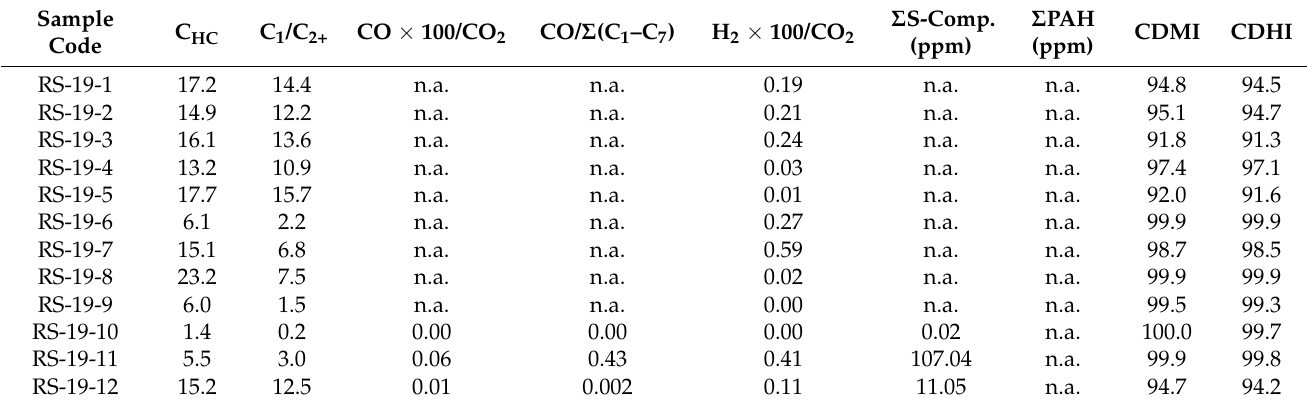
Table 2. Geochemical indices of gases collected from Rymer waste